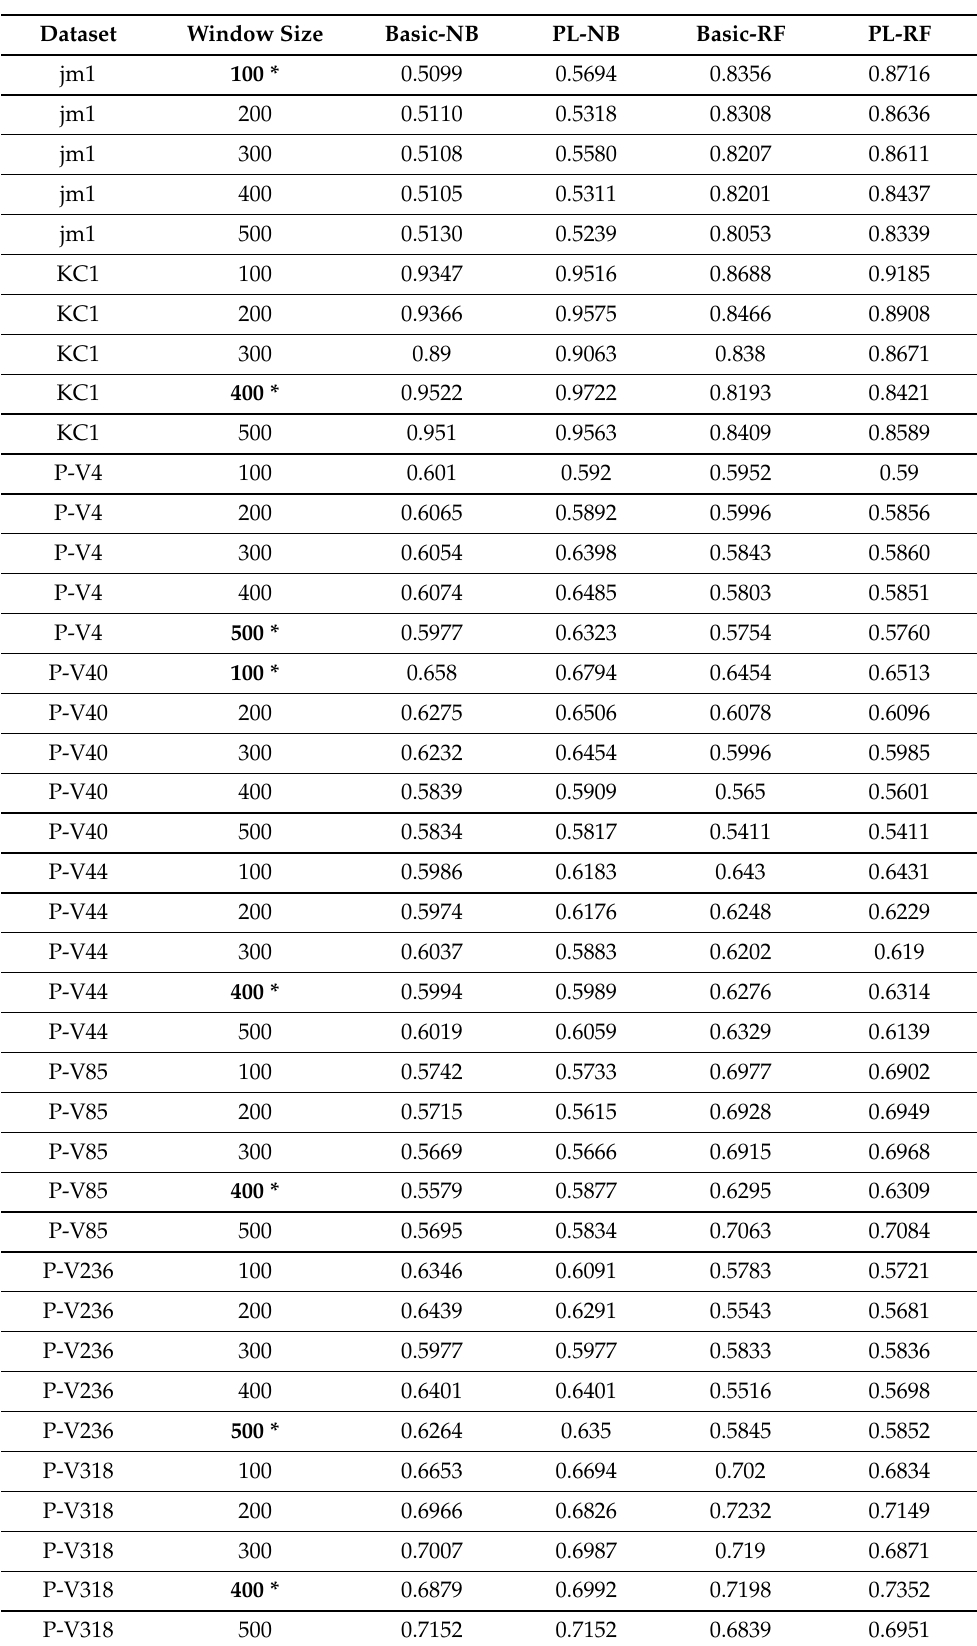
Table 5. ROC-AUC scores of the models for various window